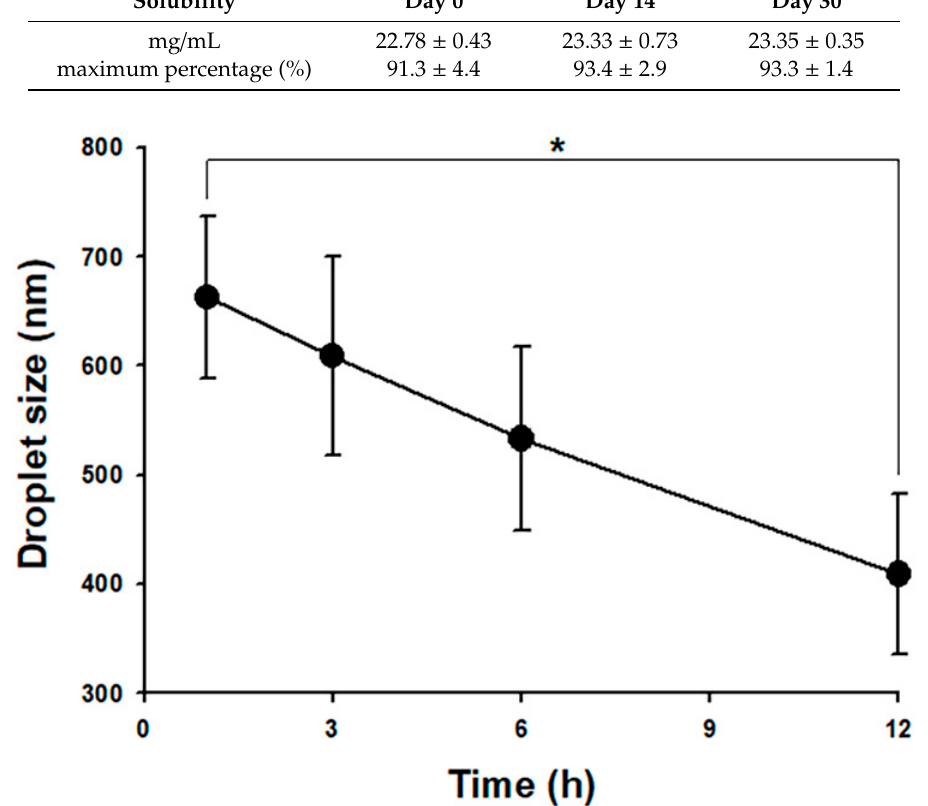
Figure 2. Serum stability of formulation B. Formulation B slightly reduced its droplet size and can be stable for at least 6h in serum. * p < 0.05. Mean ± SD, n = 3.